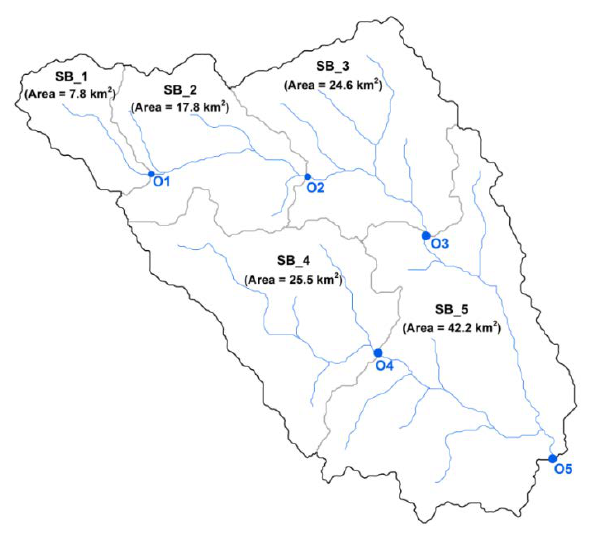
Figure 3. Sub-basin (SB) profile for the HEC-HMS model set-up.